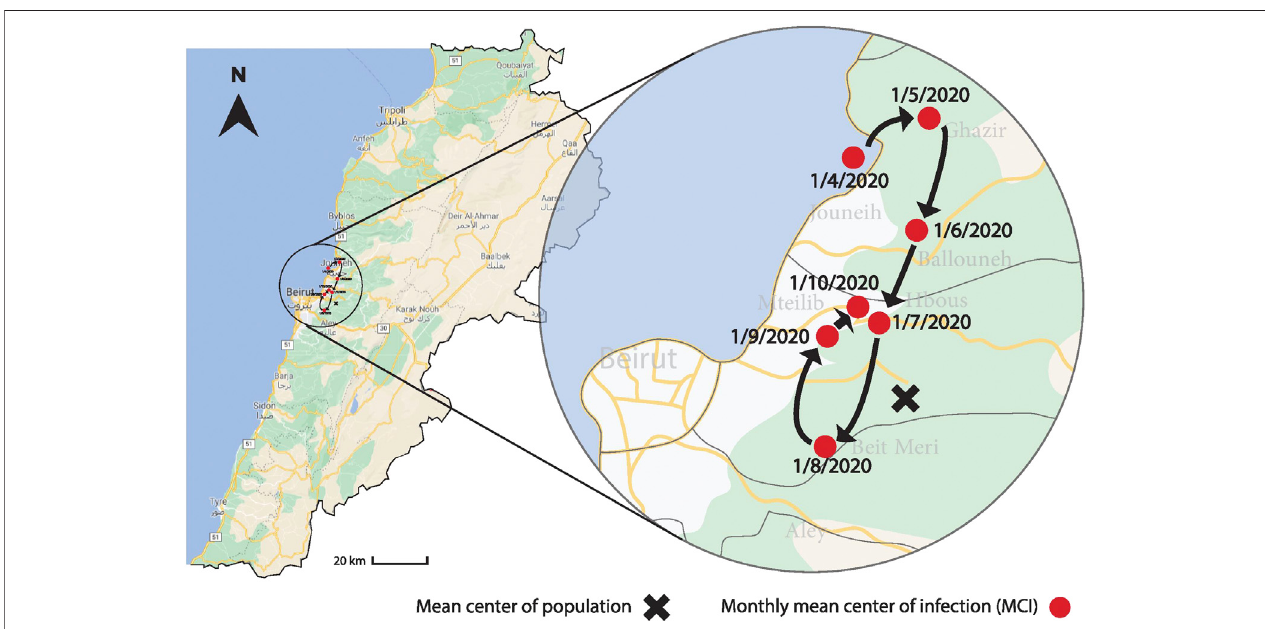
FIGURE 6 | The fi gure shows the variation of the geographic location of the MCI on a monthly basis between April 1 and October 1, 2020, together with the mean centerofthepopulation.TheMCIstartednearthecityofJounieh,north-westofthemeancenterofpopulation,butithasmovedsouthwardsinceMayuntilAugust,when it started moving northward